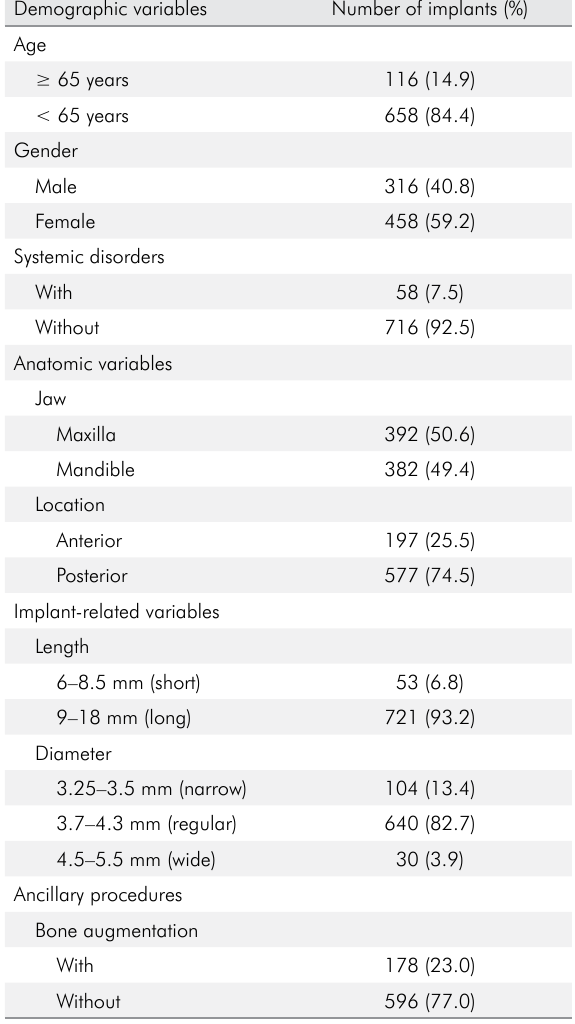
Table 1. Baseline information (n =